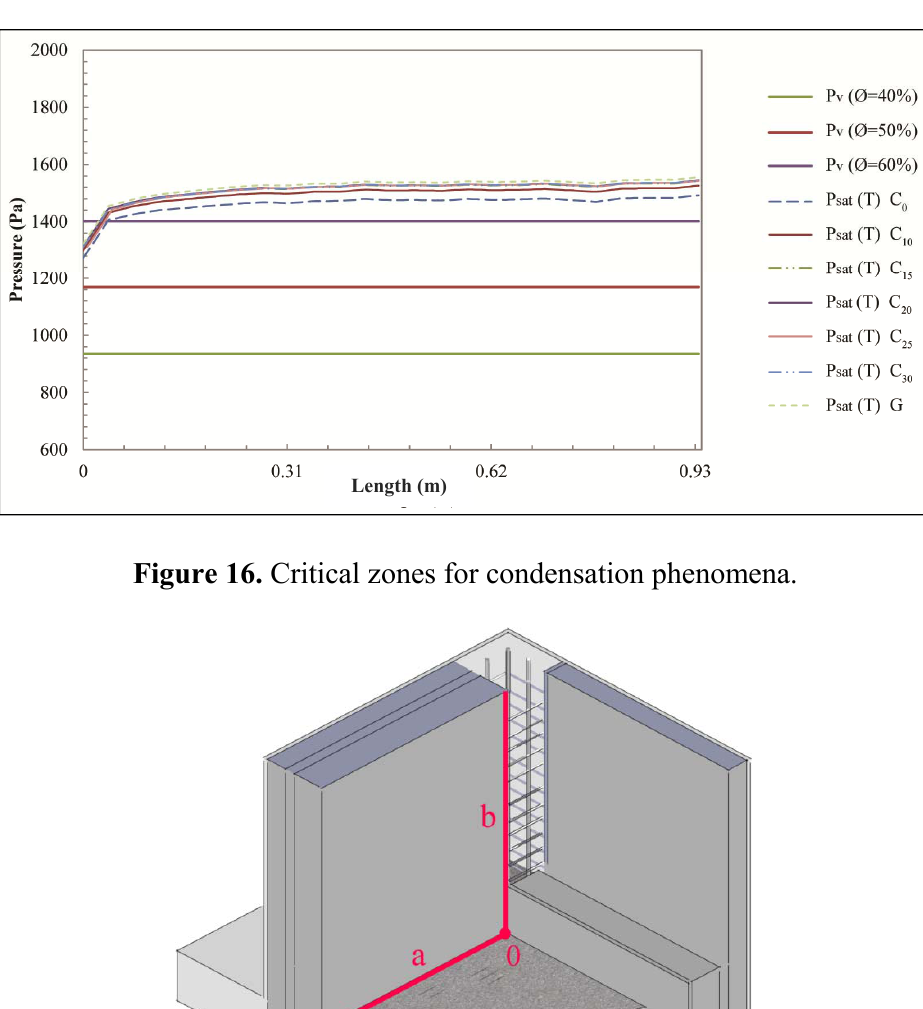
Figure 15. Partial pressure of vapor and saturation pressure of water on the corner between the two vertical walls (corner “b” of Figure 16).